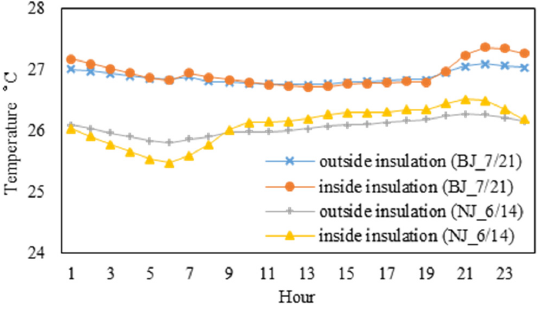
Figure 11. Inside face temperatures of external opaque walls with different structures in north perimeter zones with ESCS.